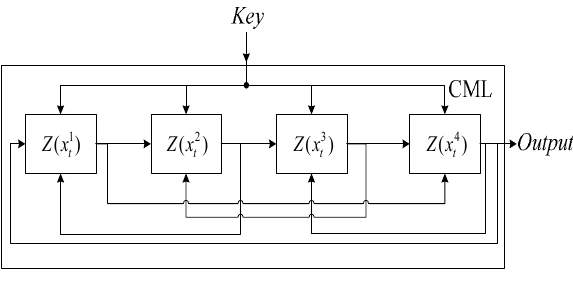
map, i is a counter and Q = 512 is a fixed integer.